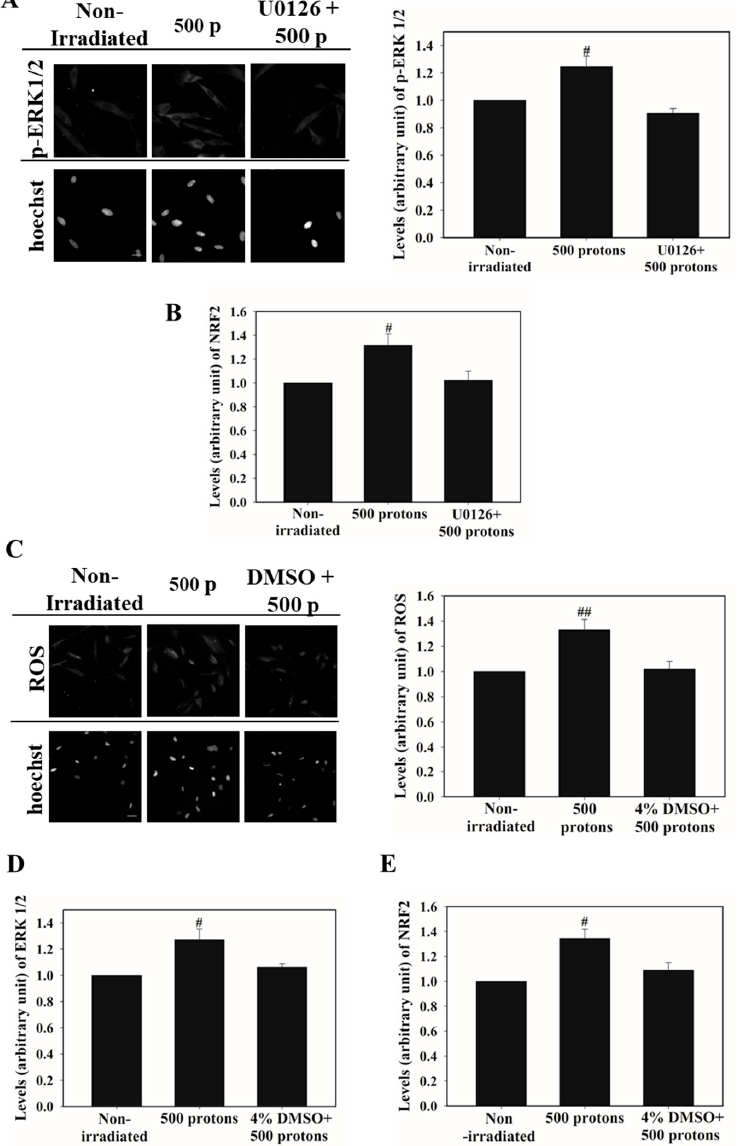
Figure 5. The WI-38 cells were treated or mock treated with 2.5 µmol/L U0126 for 30 min and then exposed to 500 proton nucleus irradiation. Immunofluorescence labeling was used to determine the levels of phosphorylated ERK 1/2 12 h later. Scale bar = 30 µm ( A ), and the WI-38 cells were treated with U0126 and nucleus targeted irradiation according to the conditions described in Figure 5A. Then, the nucleus accumulation of NRF2 was detected by immunofluorescence staining ( B ). Prior to and following 500 proton irradiation, the WI-38 cells were treated with 4% DMSO for 30 min, respectively. Then, the ROS levels were measured with hydroethidine, as described in the “Materials and Methods”. Scale bar = 50 µm ( C ). The WI-38 cells were treated with DMSO and nucleus irradiation using the same conditions in Figure 5C. Immunofluorescence labeling was used to determine the levels of phosphorylated ERK 1/2 ( D ) and nucleus accumulation of NRF2 ( E ) 12 h after irradiation. # P value < 0.05. ## P value < 0.01.